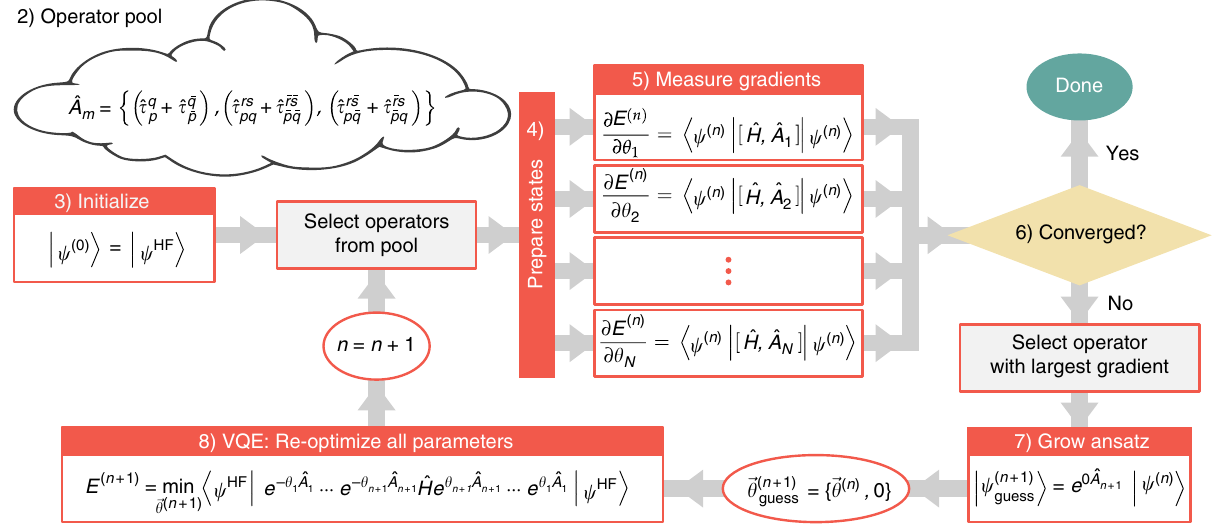
Fig. 1 Schematic depiction of the ADAPT-VQE algorithm described presented. Since step 1 occurs on classical hardware, it is not included in the illustration. ~ θ ð n Þ is the list of ansatz parameters at the n th iteration. The number of parameters, len ~ θ ð n Þ ð Þ , is equal to the number of operators in the ansatz. “ Operator Pool ” refers to the collection of operators which are used to grow the ansatz one-at-a-time. Each τ q p represents a generalized single or double excitation, and these operators are then spin-complemented. The orbital indices refer to spatial orbitals, and the overbar indicates β spin. Orbital indices without overbars have α spin. Note that growing the ansatz does not drain the pool, and so operators can show up multiple times if selected by the